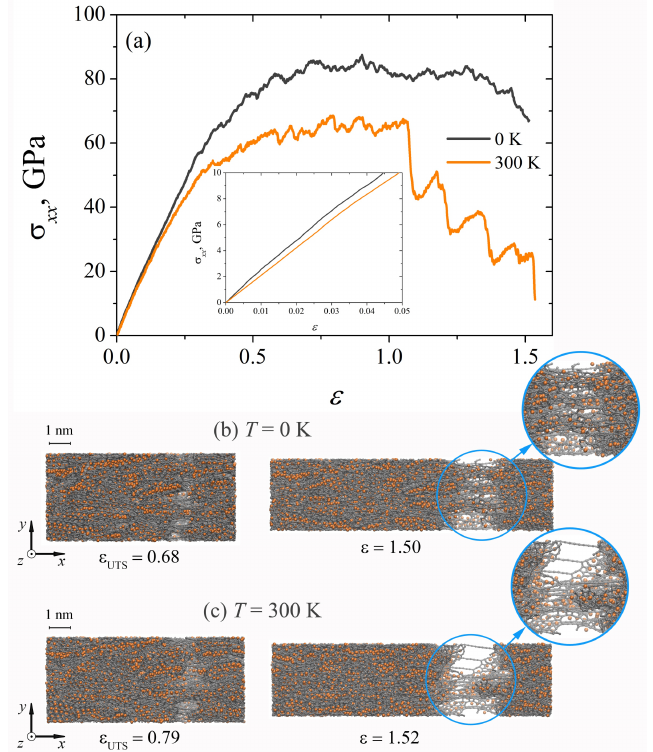
Figure 5. ( a ) Stress–strain curves during uniaxial dynamic tension at ˙ ε = 5 × 10 − 3 ps − 1 for two tem- peratures: 0 K and 300 K. ( b , c ) The snapshots of Ni/graphene composite at 0 and 300 K, respectively. Colors as in Figure